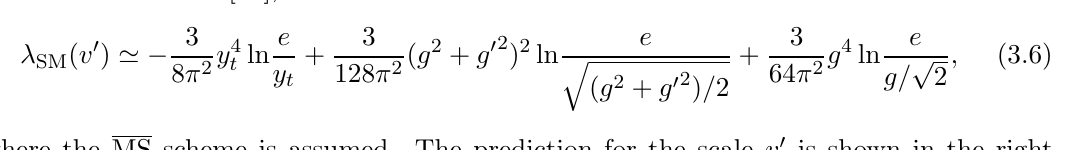
Figure 2 . (Left) Running of the SM quartic coupling. (Right) Predictions for the scale v function of m t